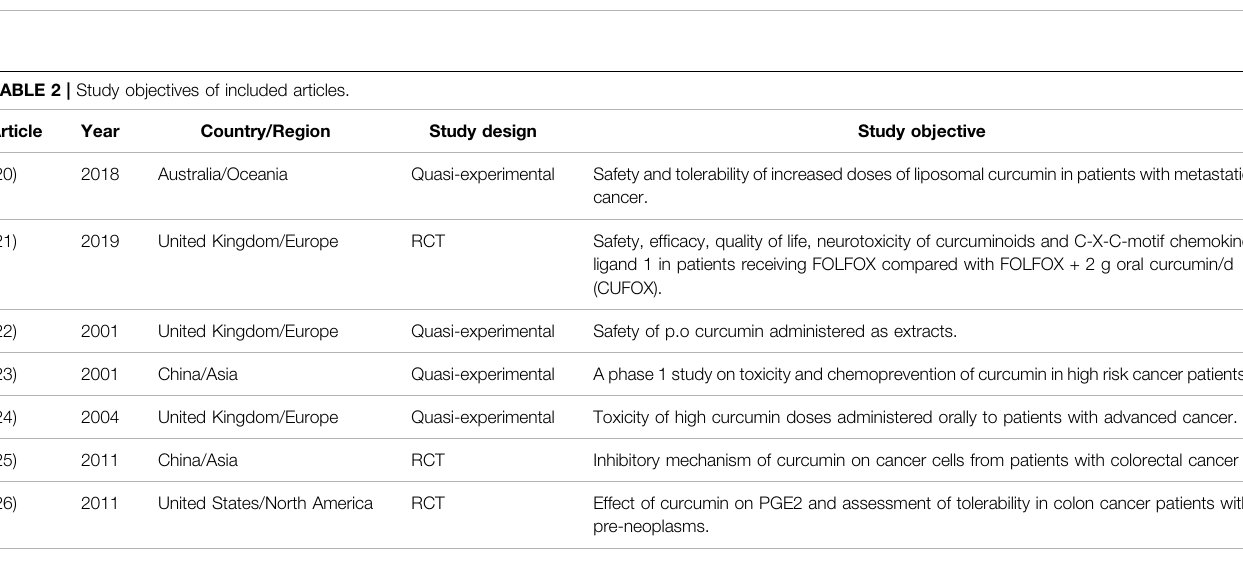
Medline SOCPUS [TITLE-ABS-KEY ( “ Colonic Neoplasms ” OR “ Colon cancer ” )] AND [TITLE-ABS-KEY (curcumin OR turmeric OR “ curcuma longa ” )] AND [TITLE-ABS-KEY ( “ Antineoplastic Agents" OR "Anti-Cancer Agents" )]